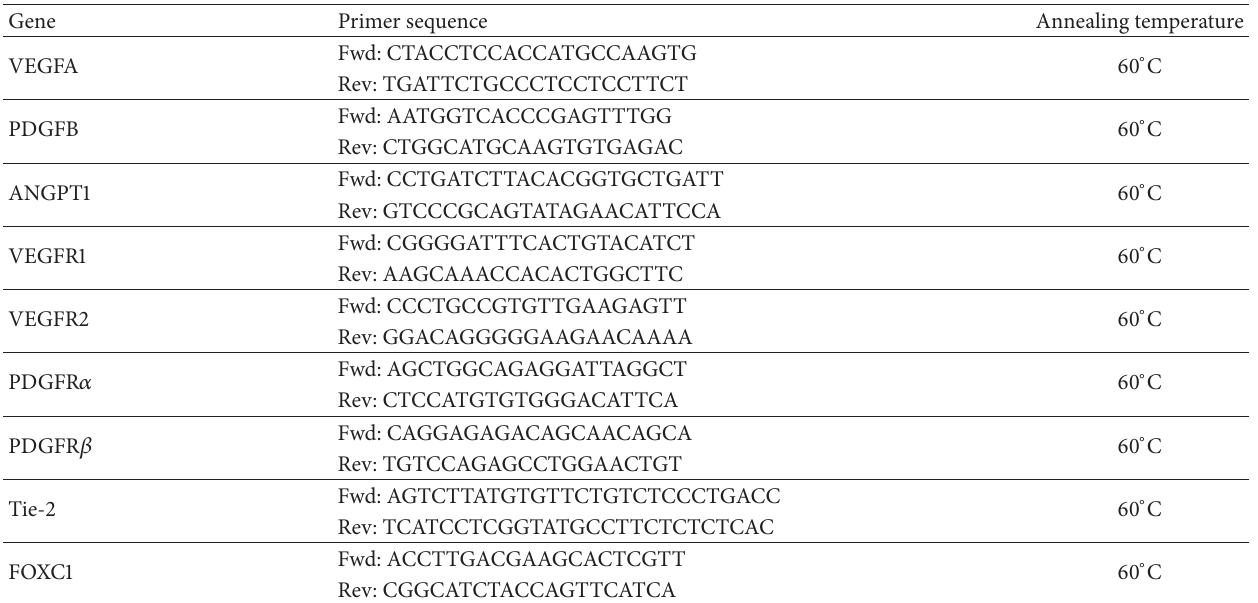
Table 2: Primer sequences and annealing